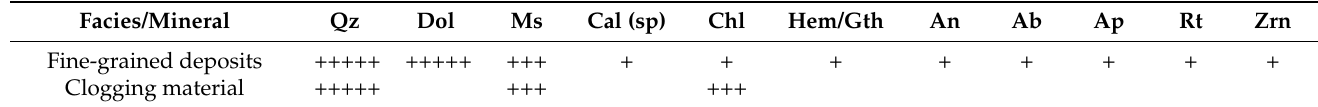
Figure 5. ( A , B ) Transmitted-light, crossed-polarized, thin-section photomicrographs of fine-grained deposits from Selinitsa Cave. Detrital, angular–subangular quartz clasts (Qz) and euhedral to subhedral authigenic dolomite (Dol) predominate, whereas small lithic clasts (LC) are also observed. ( C ) Back-scattered electron microphotograph of Selinitsa fine-grained deposits. The presence of euhedral to subhedral authigenic dolomite (dol) and detrital, angular quartz fragments (Qz) is evident. Minor muscovite clasts (Ms) are also present, along with traces of anhedral calcite (Cal). ( D ) Back-scattered electron microphotograph of a lithic clast (LC) from Selinitsa fine-grained deposits with predominating angular to subangular quartz (Qz) clasts, minor muscovite laths (Ms), and traces of anhedral calcite. Mineral abbreviations taken from [34]. Table 1. Semi-quantitative mineralogical analyses of the different deposit facies in Selinitsa Cave identified by optical microscopy, X-ray diffraction, Raman spectroscopy, and scanning electron